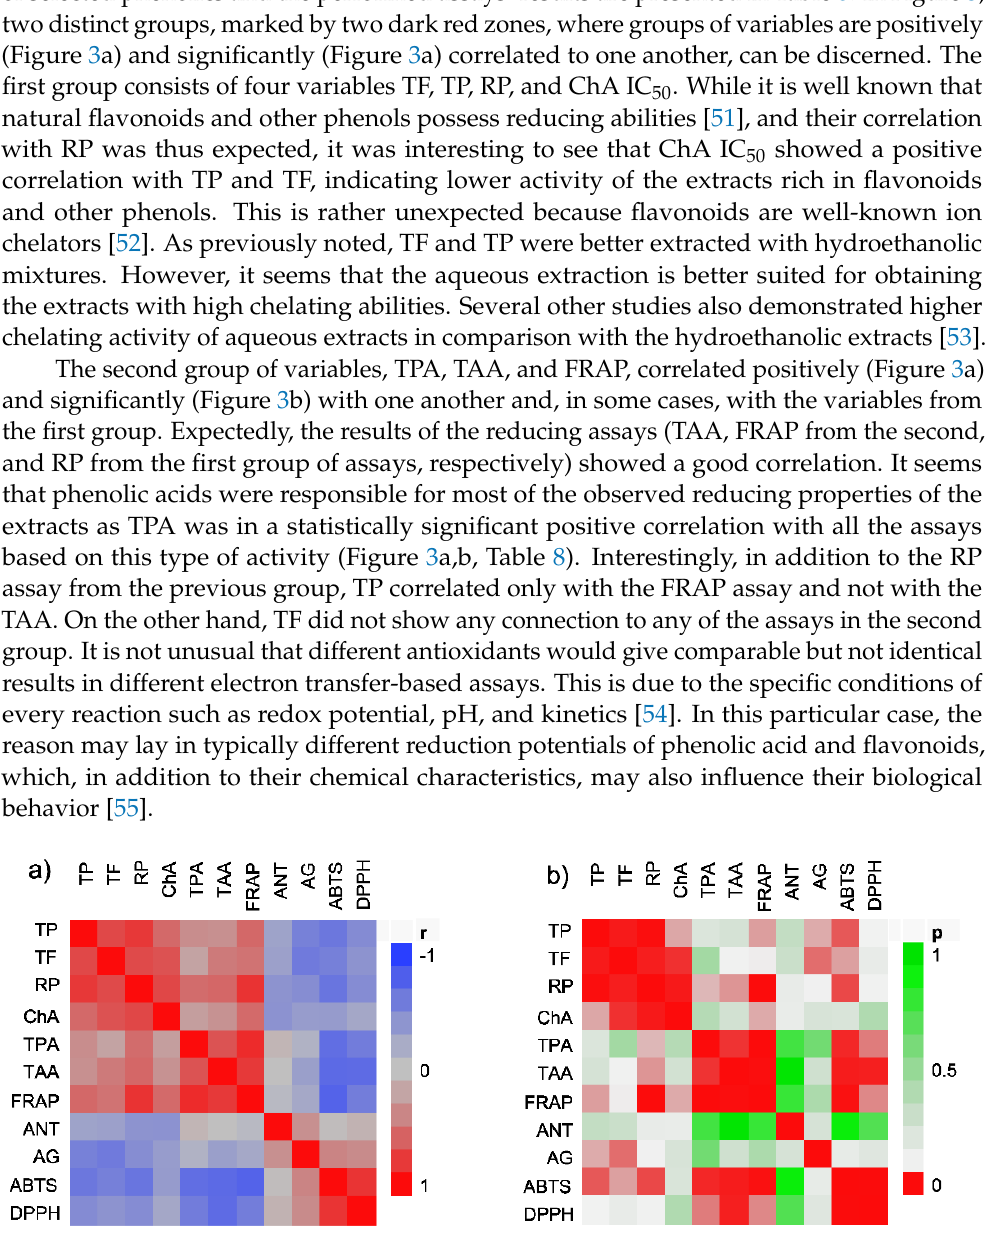
Figure 3. Color maps of correlations between the measured variables ( a ) and corresponding p - values ( b ). TP = total phenolic content; TF = total flavonoid content; TPA = total phenolic acid content; ABTS = IC 50 value of radical scavenging activity for ABTS free radical; DPPH = IC 50 value of radical scavenging activity for DPPH free radical; ChA = IC 50 value of chelating activity; ANT = antioxidant activity in β -carotene-linoleate assay; TAA = total antioxidant activity; RP = reducing power; FRAP = ferric reducing power; AG = IC 50 value of α -glucosidase inhibiting activity. Table 8. Coefficients of determination for significant ( p < 0) correlations between the content of phenolic compounds (TP, TF, and TPA) and antioxidant activity.